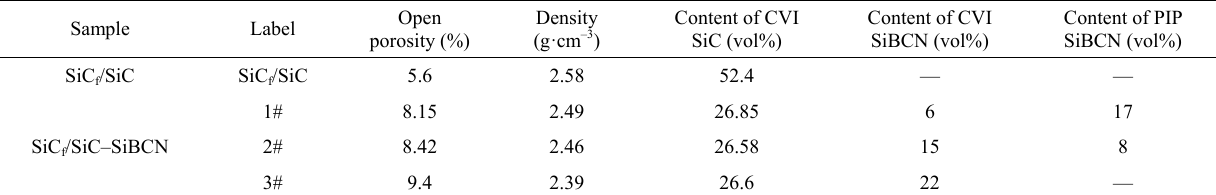
Table 1 Intrinsic parameters of as-fabricated SiC f /SiC–SiBCN composites